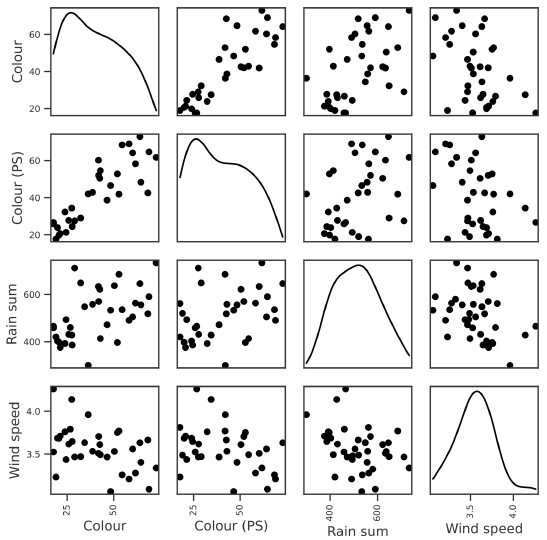
Figure 6. Relationships between seasonal mean lake colour and po- tential explanatory variables of interest, including the colour during the previous summer (PS), seasonal rain sum, and mean wind speed. Density plots estimated using kde are shown along the